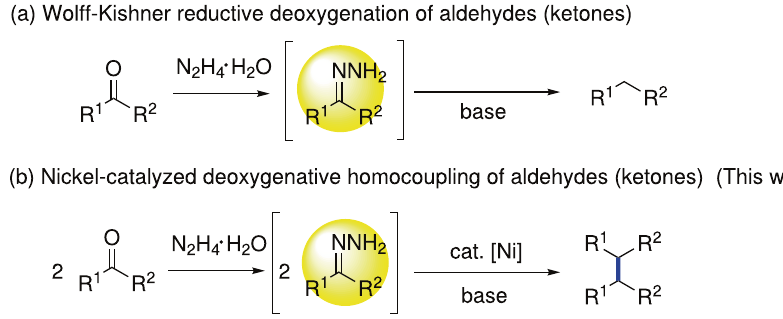
Fig. 1 Strategies for deoxygenation of aldehydes and ketones with hydrazine. a Wolff – Kishner reductive deoxygenation of aldehydes (ketones). b Nickel- catalyzed deoxygenative homocoupling of aldehydes